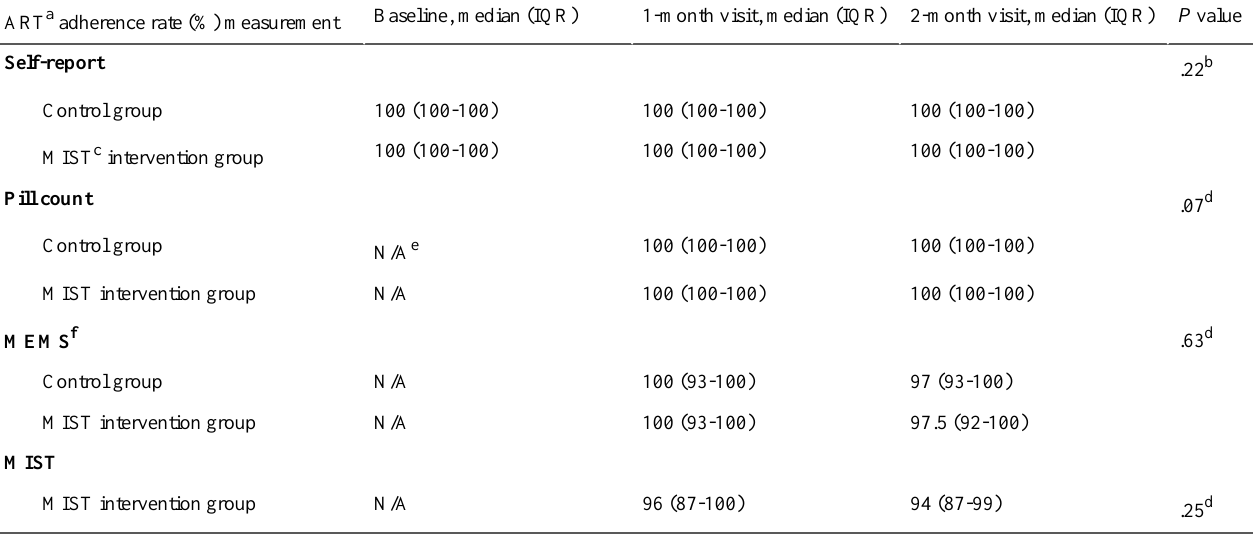
Table 2. Comparison of median antiretroviral therapy adherence rates at different time points for each group